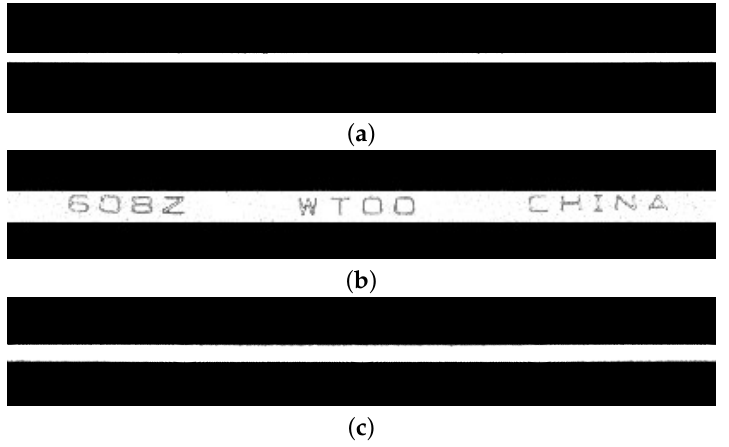
Figure 8. Results of Polar to Cartesian (P2C). ( a ) The rectangular band of outer ring. ( b ) The rectangular band of dust cover. ( c ) The rectangular band of inner